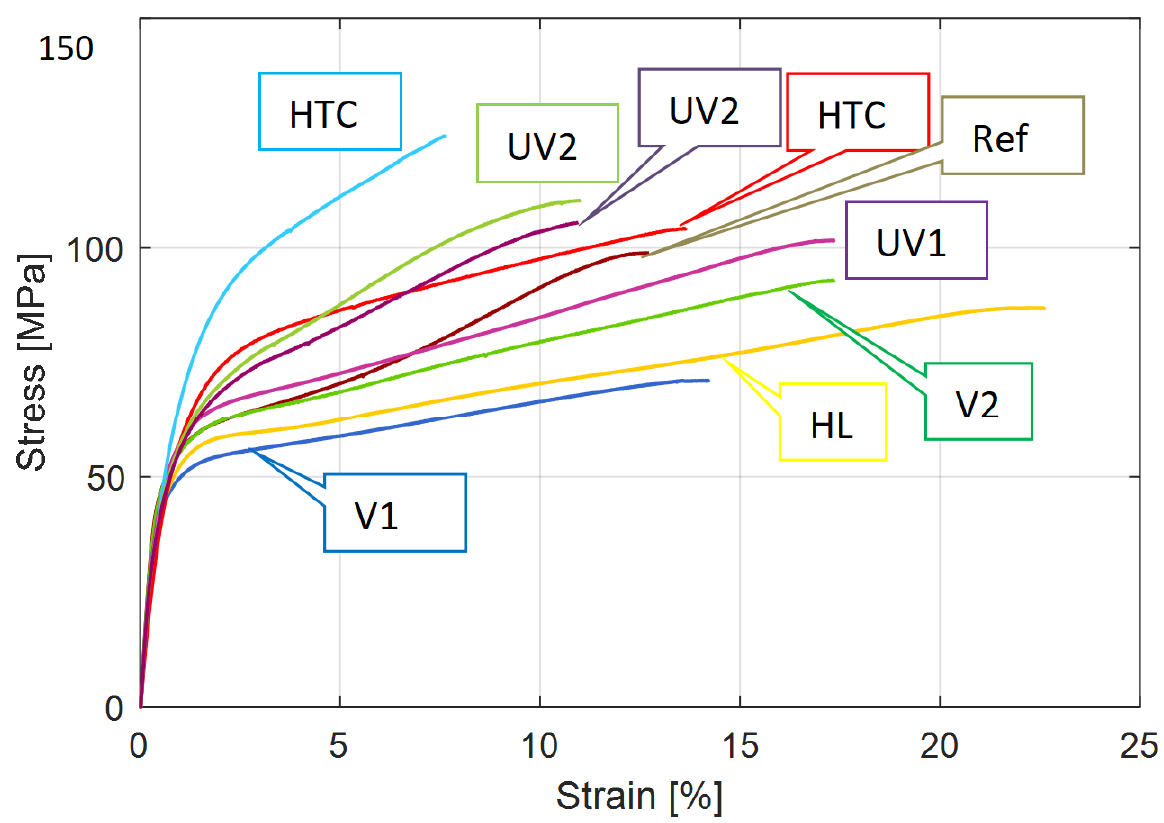
Figure 3. Typical stress-strain curves of the specimens. Here: HL—hand layup lamination, HTC— high-temperature thermal curing, UV1—ultraviolet repair with handheld, portable, continuous UV spectrum curing, UV2—ultraviolet repair with stationary device, V1—vacuum repair with hand layup, V2—vacuum repair with infusion, and Ref—reference, unrepaired sample. Table 4. Mechanical properties of repaired